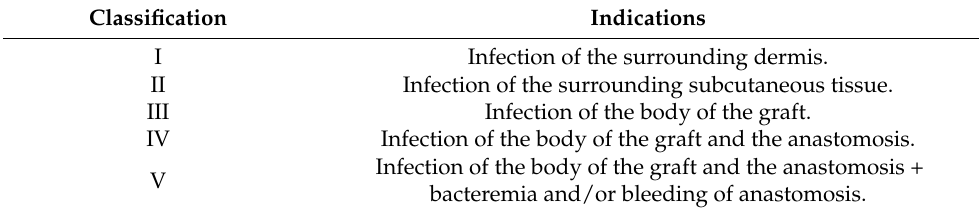
Table 2. Classification of vascular graft infections [49]. Classification Indications Infection of the surrounding